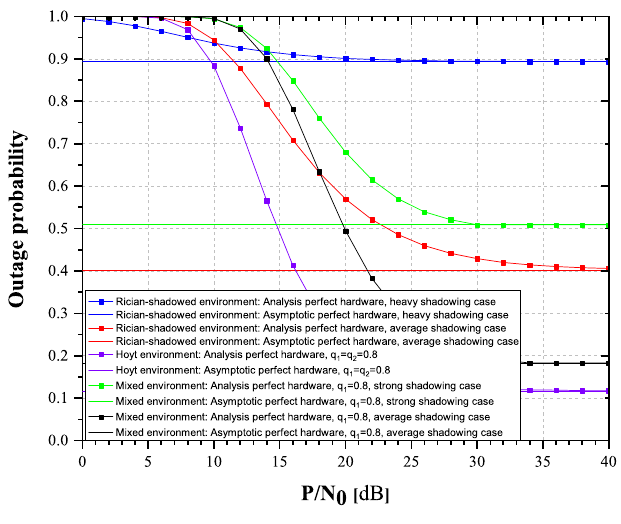
Figure 10. Influence of fading environment: Outage probability versus P / N 0 .